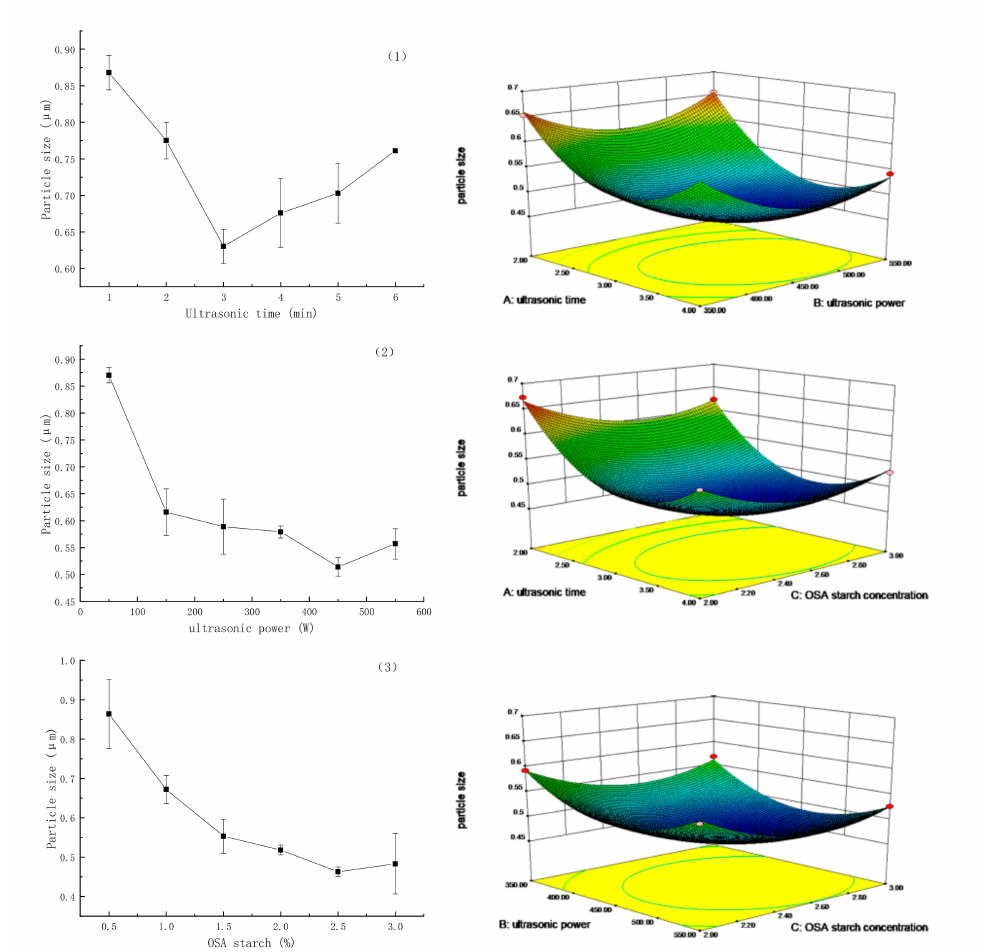
Figure 6. ( Left ) Effects of different factors on emulsion particle size. ( right ) Optimization of emulsion preparation process by response surface